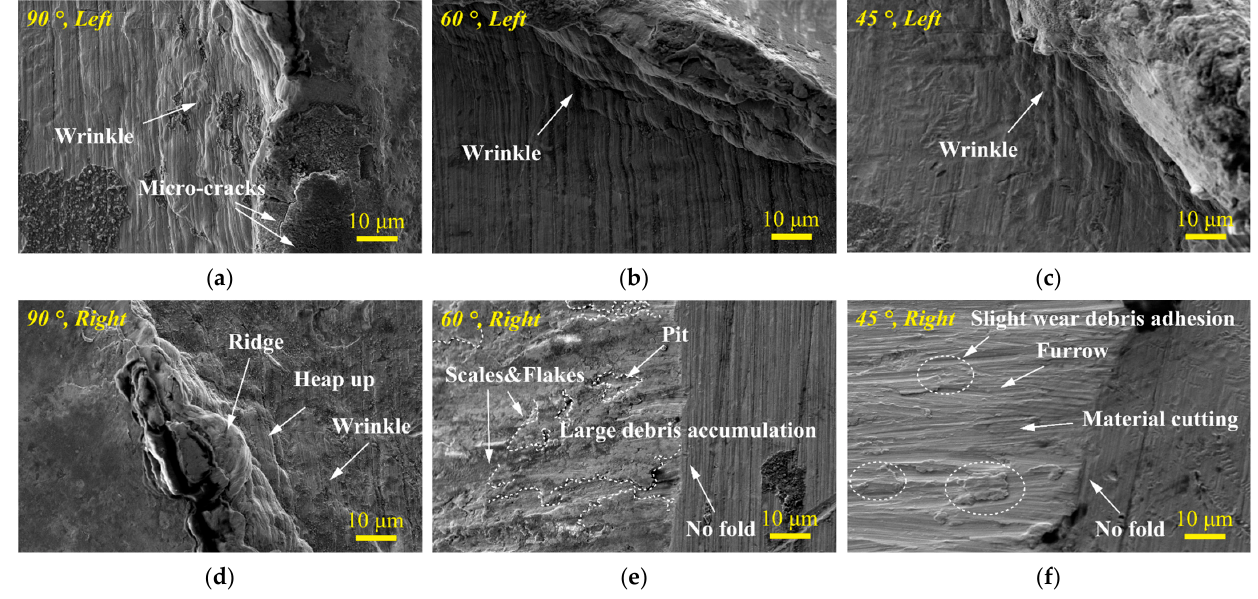
Figure 13. SEM morphology of wear scar edges under varying impact angles. ( a ) θ = 90°, left; ( b ) θ = 60°, left; ( c ) θ = 45°, left; ( d ) θ = 90°, right; ( e ) θ = 60°, right; ( f ) θ = 45°, right. ( b ) θ = 60 ◦ , left; ( c ) θ = 45 ◦ , left; ( d ) θ = 90 ◦ , right; ( e ) θ = 60 ◦ , right; ( f ) θ = 45 ◦ ,